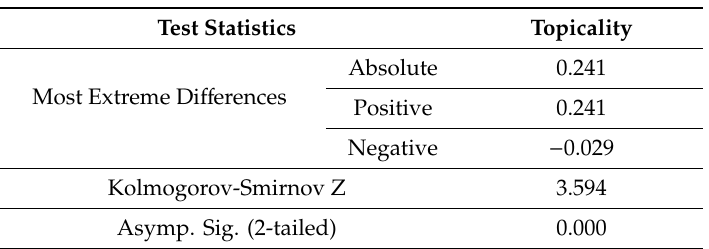
Table 4. Results of Kolmogorov-Smirnov